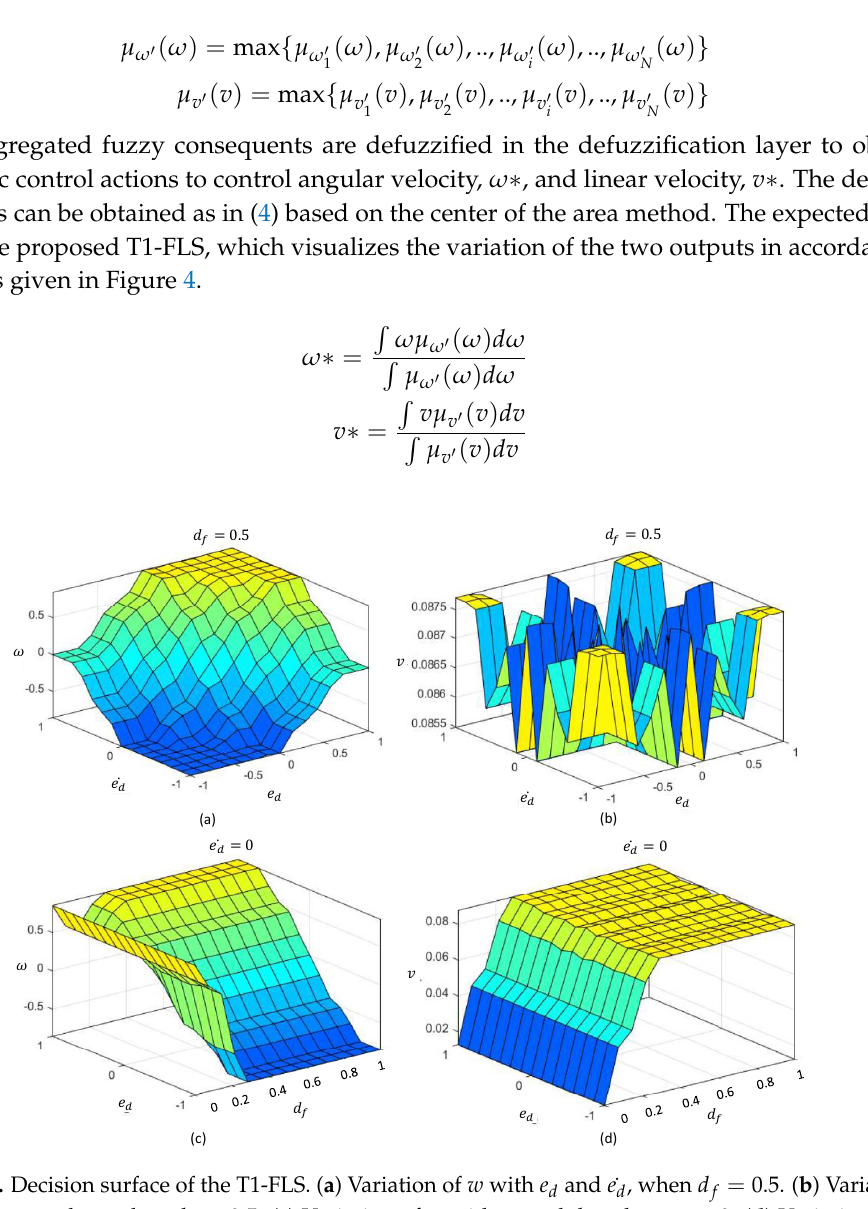
Figure 4. Decision surface of the T1-FLS. ( a ) Variation of w with e d and ˙ e d , when d f = 0.5. ( b ) Variation of v with e d and ˙ e d , when d f = 0.5. ( c ) Variation of w with e d and d f , when ˙ e d = 0. ( d ) Variation of v with e d and d f , when ˙ e d =